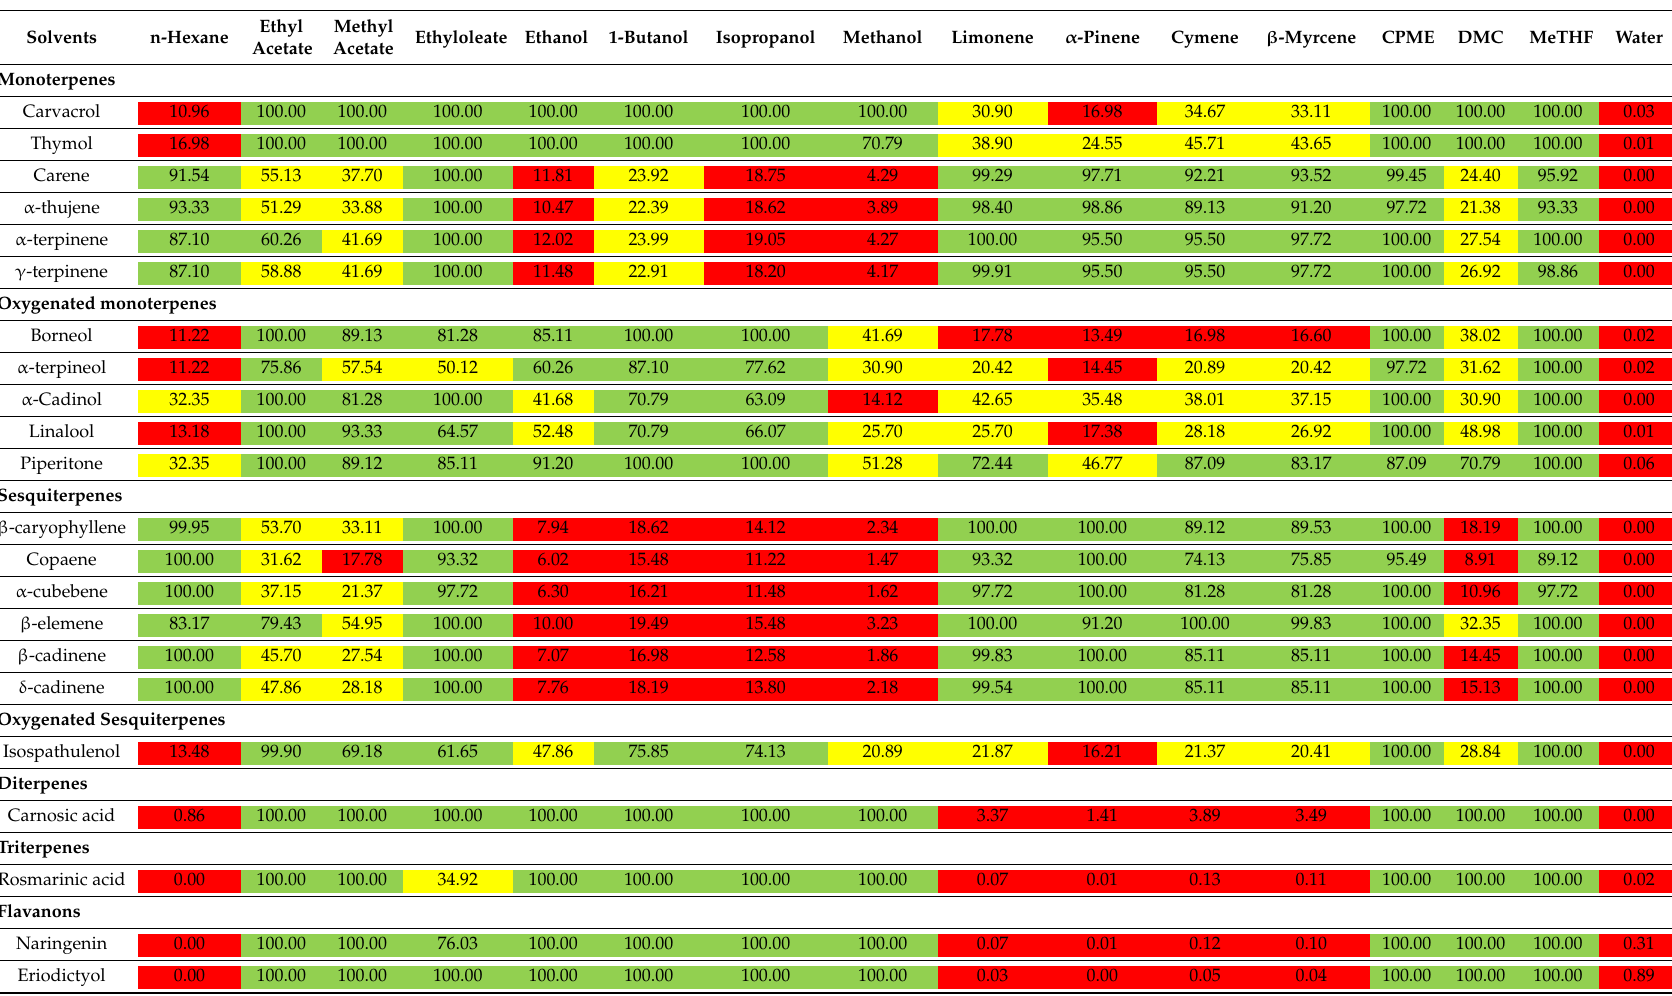
Table 2. The conductor like screening model for realistic solvents (COSMO-RS) probability of solubility (%) of bioactive compounds from wild thyme for green solvents in comparison with n